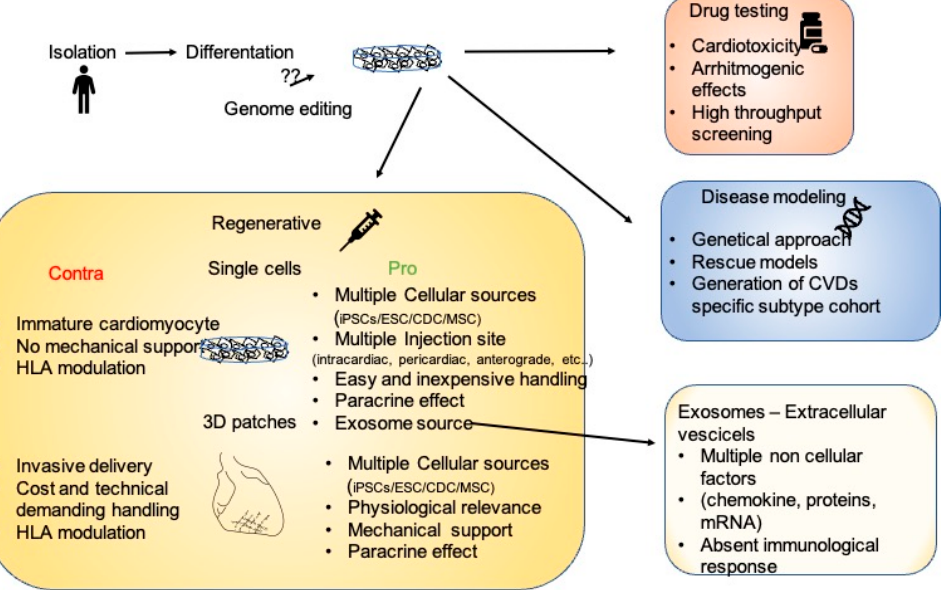
Figure 2. The many facets of iPSCs. After isolation and in vitro differentiation, iPSC cardiomyocytes could be employed as a platform for drug testing, for the modeling of multiple diseases allowing genetic characterization, or for regenerative therapies. In the regenerative scenario, the pros and cons of single cells or 3D structures are enumerated.